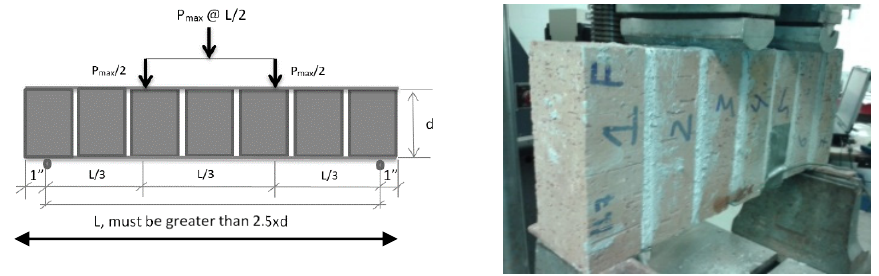
Figure 4. Flexural bond strength